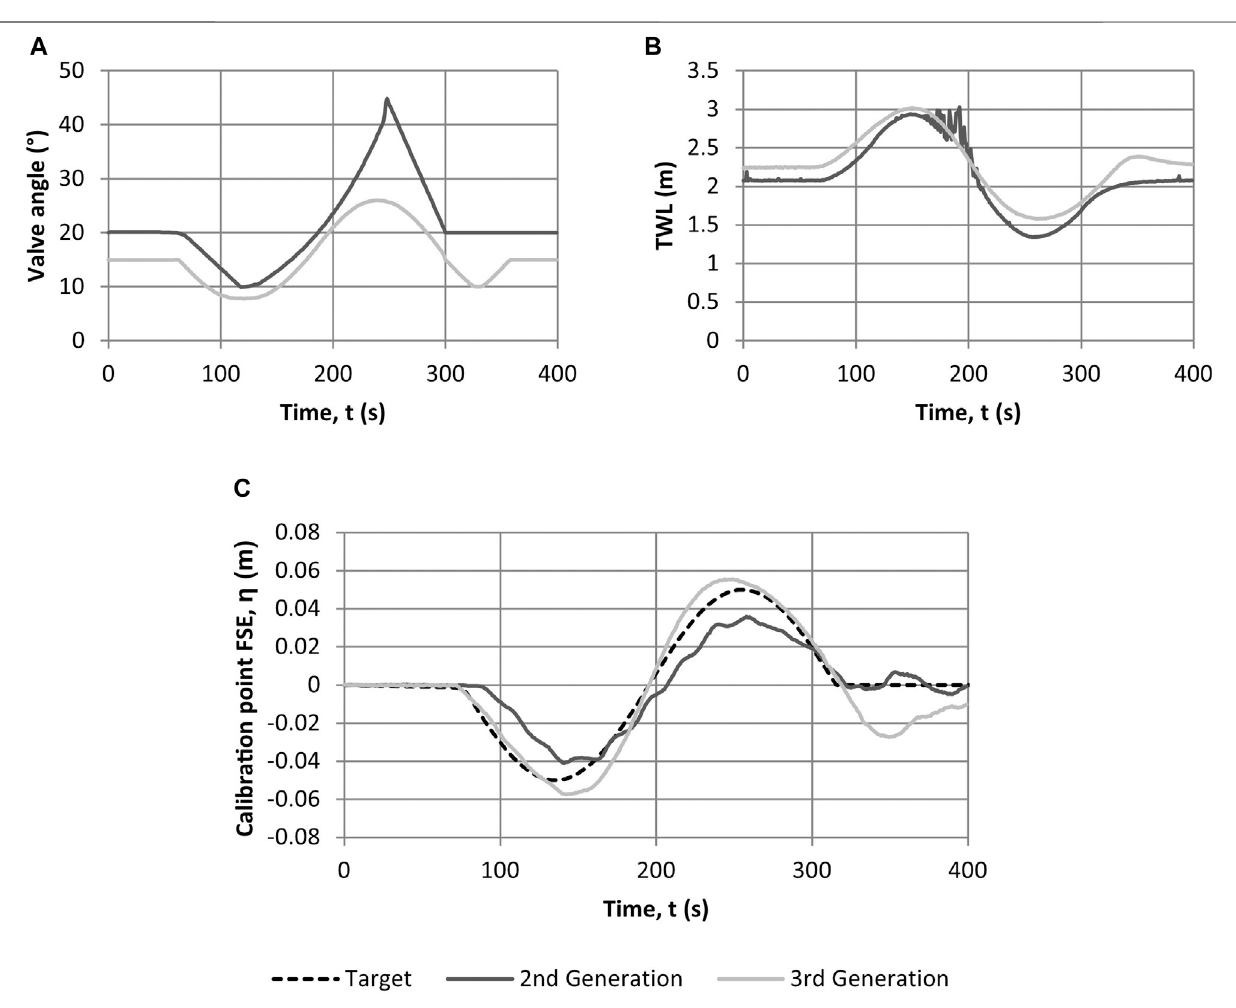
FIGURE 13 | Comparison of (A) valve angle, (B) tank water level (TWL) and (C) free-surface elevation at the calibration point for second and third generation TS (N240 wave), target (desired) pro fi le indicated with dashed line. Frontiers in Built Environment |